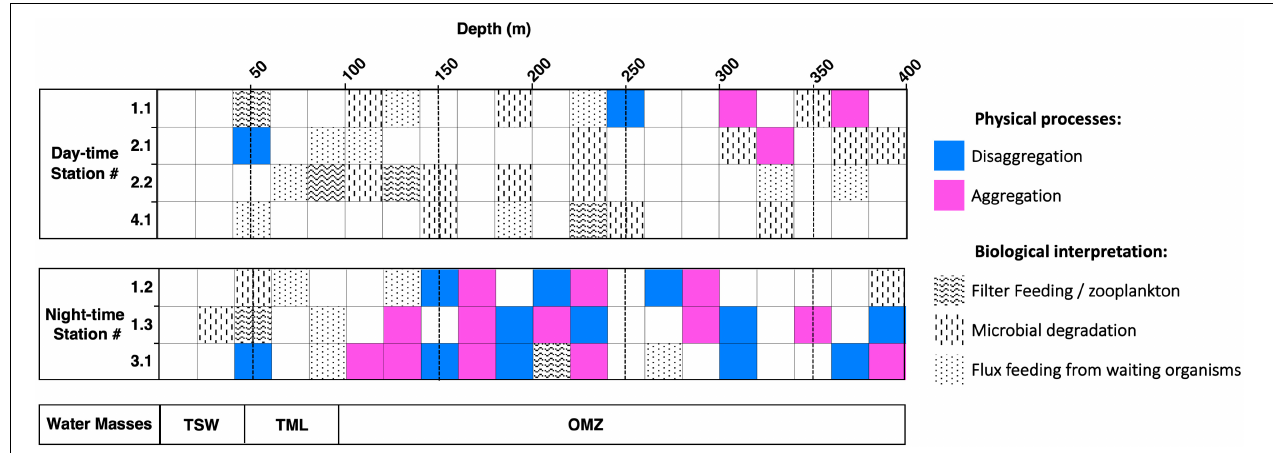
FIGURE 10 | Particle alteration interpretation of the upper section of the water column from the surface down to 400 m depth. All profiling stations were split in a day and night period. The water masses distribution is showing on the bottom: tropical surface water (TSW), thermocline layer (TML), oxygen minimum zone